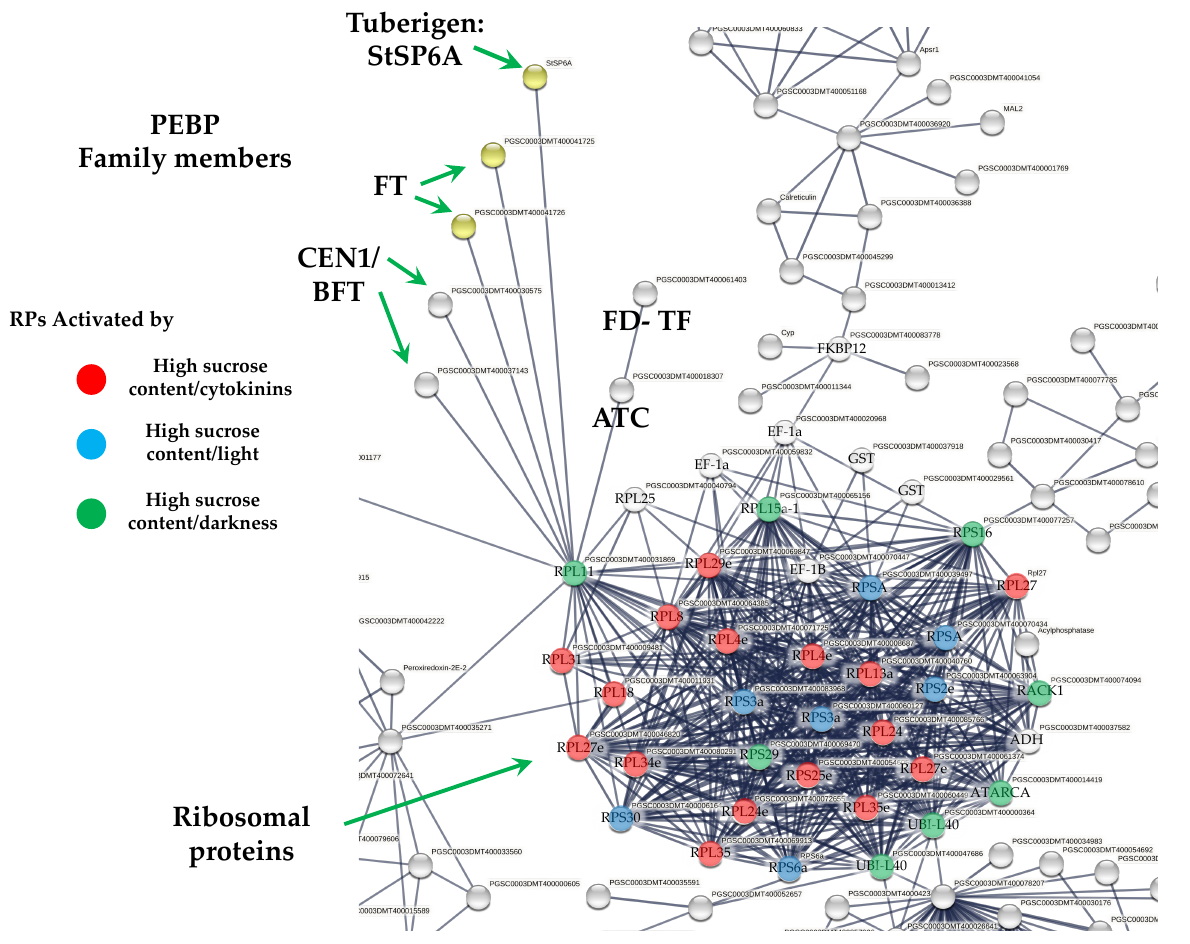
Figure 8. PPI network of up-regulated PEBP family members and RPs cluster of potato S. tuberosum from the transcriptomic-wide analysis with high confidence (0.860). Selected proteins are highlighted with the name of the gene. RPs highlighted in red, blue, and green correspond to activated proteins